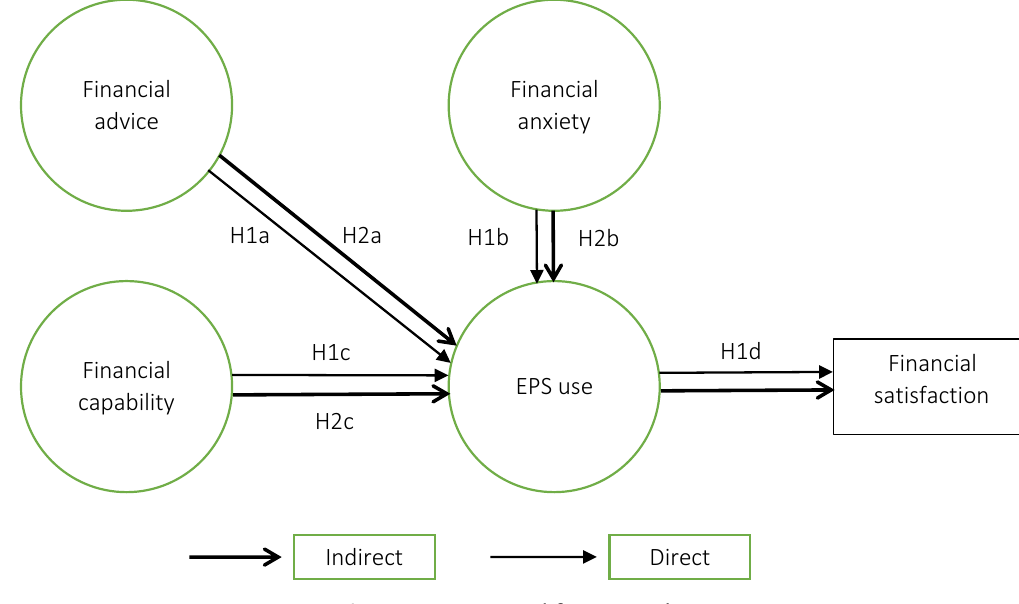
Figure 1. Proposed